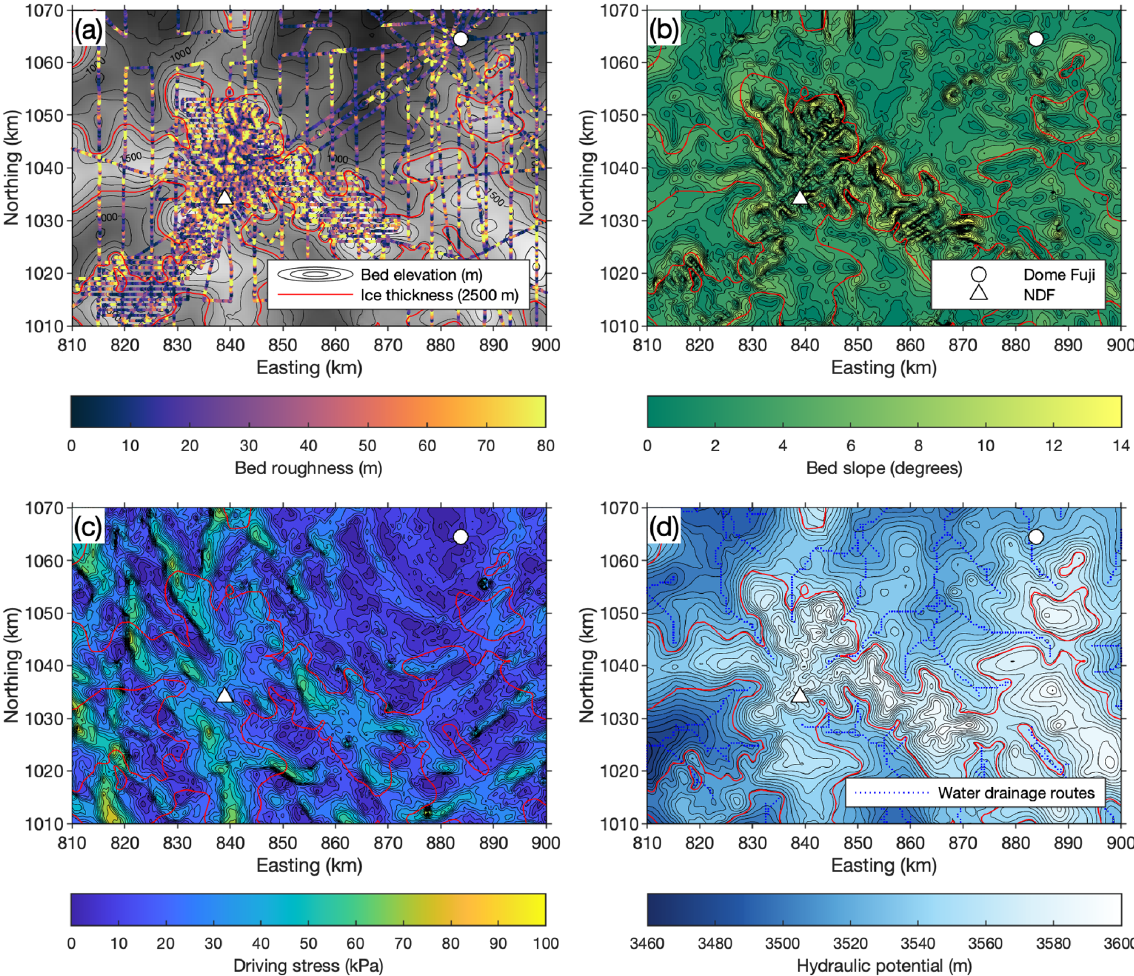
Figure 8. (a) Bed roughness superimposed on new bed elevation data (in greyscale) and (b) the bed slope. Bed elevation contours in (a) have intervals of 100m. (c) Driving stress using the new ice thickness data and the CryoSat-2 surface DEM (Helm et al., 2014). (d) Hydraulic potential using the new ice thickness and bed elevation data. The estimated drainage routes of the subglacial water are indicated with blue dots. The red contours in all plots indicate an ice thickness of